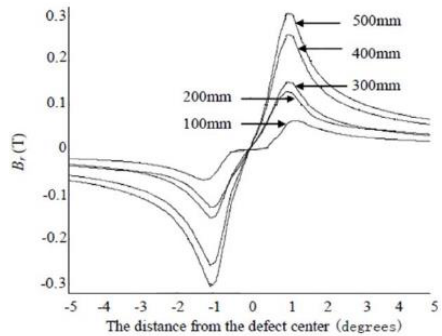
Figure 7. Circumferential MFL signals with different depth.